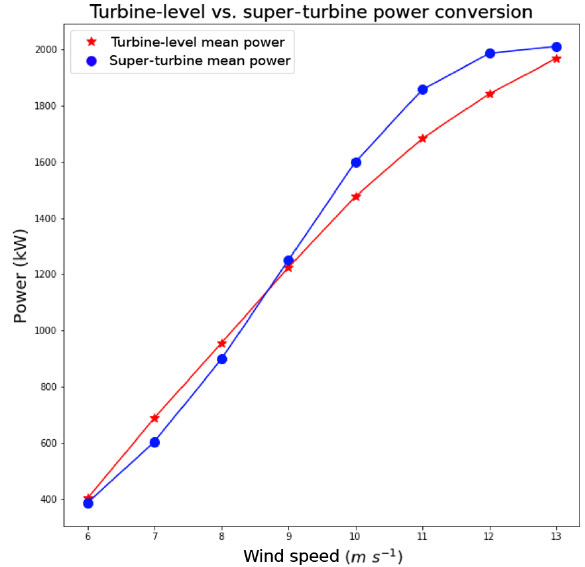
Figure 4. Comparison of the turbine-level power conversion to the super-turbine power conversion for the hypothetical wind farm with 2ms − 1 standard deviation across the turbines. Table 2. Difference of the super-turbine power conversion sub- tracted from the turbine-level power conversion for the hypothetical wind farm of 100 turbines with 2ms − 1 variability simulated 1000 times. The p value indicates statistical significance at the 95% level for a two-sample related t